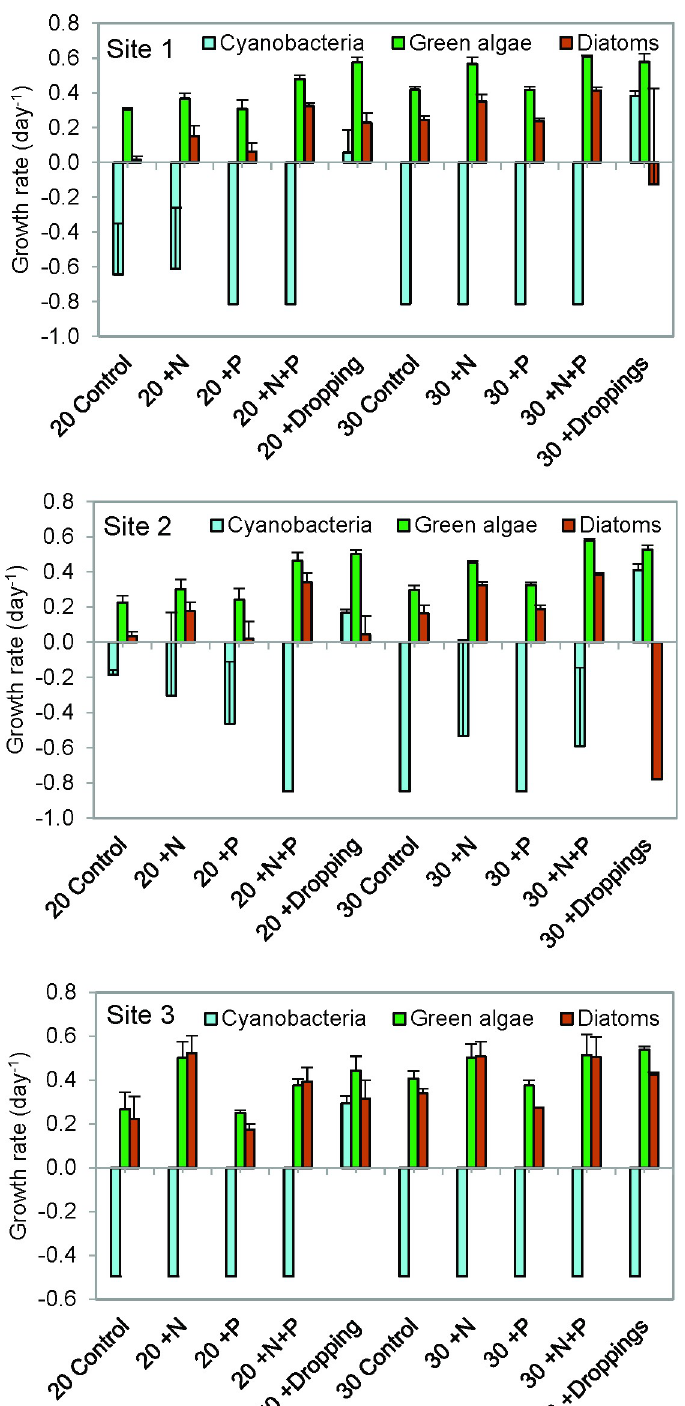
Fig 4. Algal growth rates in the algal bioassay. Growth rates (day -1 ) for cyanobacteria (blue), green algae (green) and diatoms (brown) based on PHYTO-PAM chlorophyll-a concentrations ( μ g L -1 ) in surface water sampled from three locations (Sites 1, 2 and 3) in Lake Lesser Prespa. The water had been incubated for seven days at 20˚C and 30˚C, without extra nutrients added (Control), with solely N-added (+N), solely P-added (+P), both N+P added (+N+P) and pelican droppings added (Dropping). Error bars indicate the standard deviation (n =